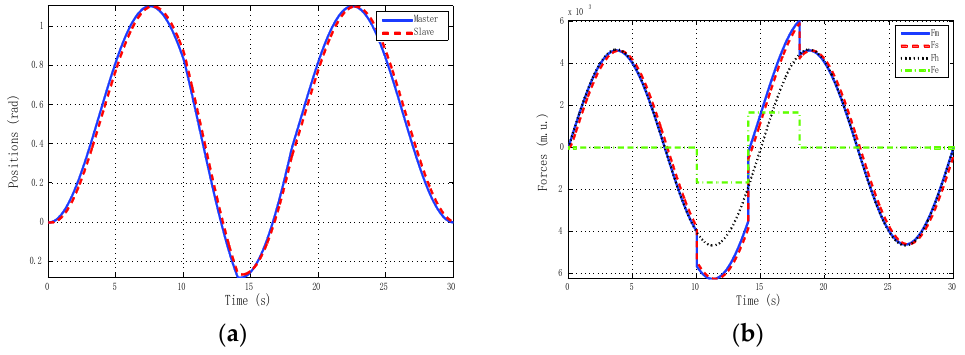
Figure 6. Simulated sine reference force: 3C-i control scheme with h max = 0, d = 0. ( a ) Positions; ( b ) Forces.